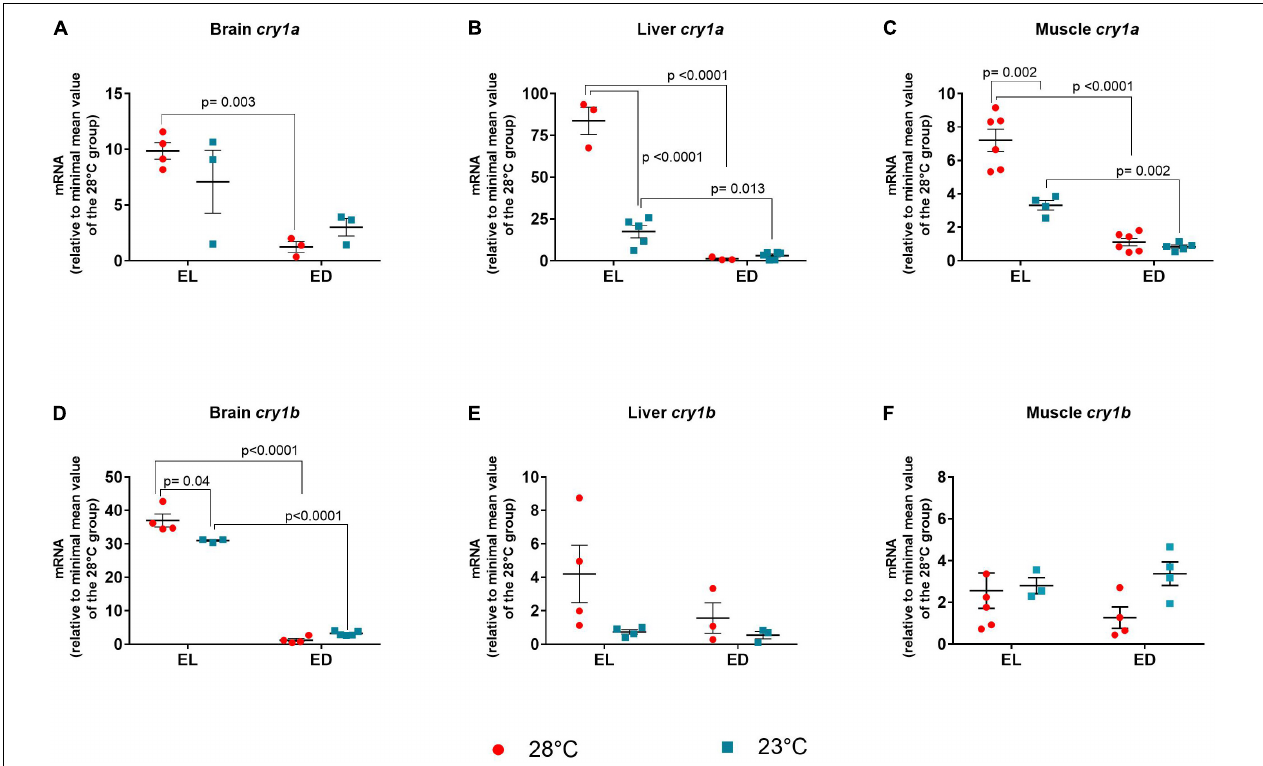
FIGURE 7 | Early light (EL) and early dark (ED) expression of cryptochrome ( cry1a and cry1b ) genes in adult Danio rerio . (A) Brain cry1a ; (B) liver cry1a ; (C) muscle cry1a ; (D) brain cry1b ; (E) liver cry1b ; (F) muscle cry1b. The gene expression was normalized by the 18S rRNA and expressed relative to the lowest mean of the control temperature group. The values are expressed as mean ± SEM. n = 3–6 (pools of four animals each). Significant differences are shown when p < 0.05. Red symbol corresponds to 28 o C and blue symbol corresponds to 23 o